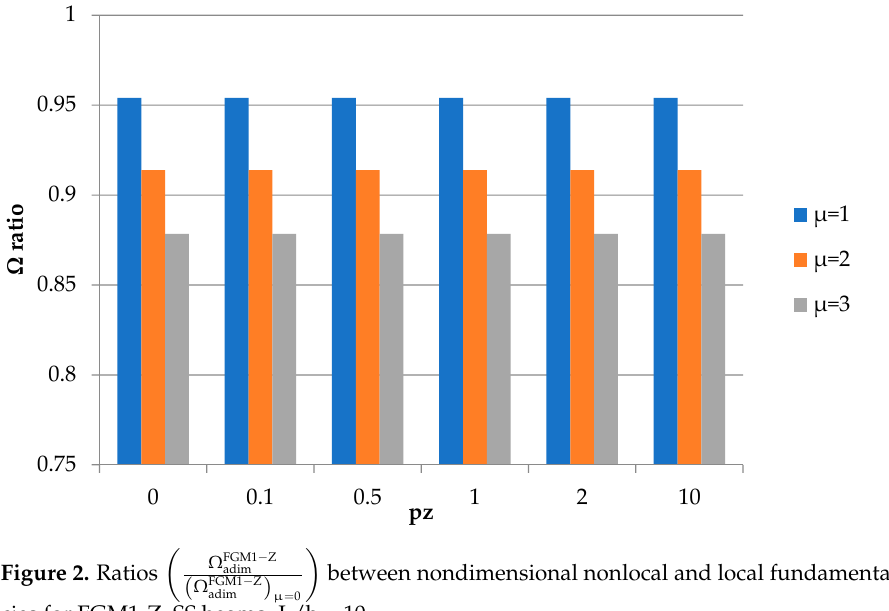
(cid:18) (cid:19) Ω FGM1 − Z (cid:3159)(cid:3162)(cid:3167)(cid:3171)(cid:3138)(cid:3139)(cid:3145)(cid:3117)(cid:3127)(cid:3158) Figure 2. Ratios between nondimensional nonlocal and local fundamental frequen- adim (cid:4679) between nondimensional nonlocal and local fundamental frequen- Figure 2. Ratios (cid:4678) (cid:2960) ( Ω FGM1 − Z ) (cid:3435) (cid:2960) (cid:3159)(cid:3162)(cid:3167)(cid:3171) (cid:3138)(cid:3139)(cid:3145)(cid:3117)(cid:3127)(cid:3158) (cid:3439) adim µ = 0 (cid:3220)(cid:3128)(cid:3116) cies for FGM1-Z, SS beams. L/h = 10. cies for FGM1-Z, SS beams. L/h = 10.